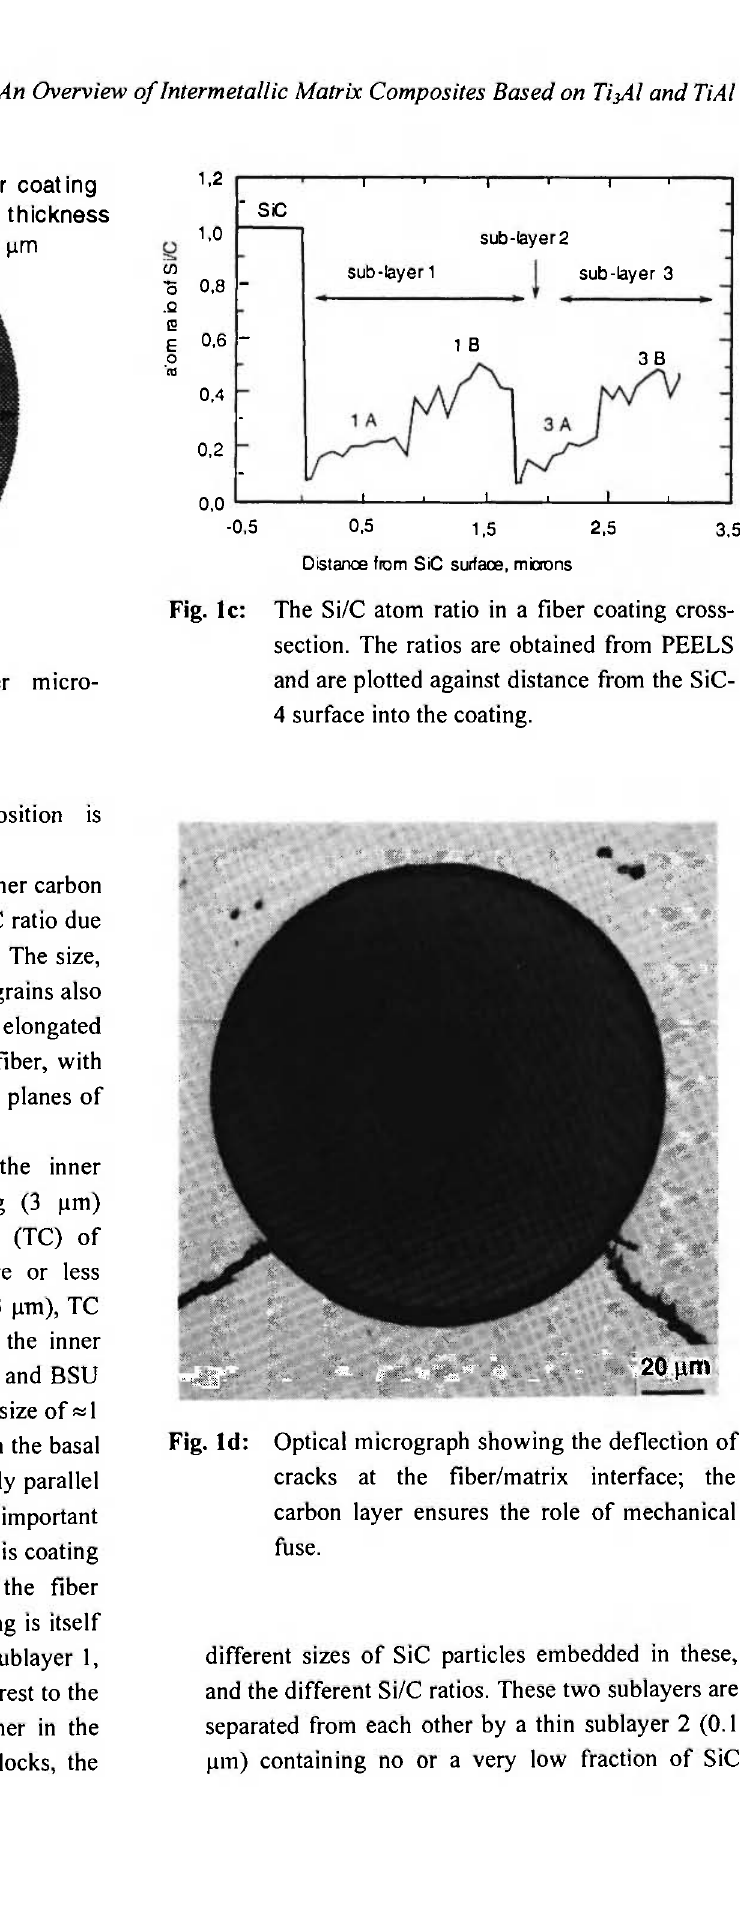
Fig. lc: The Si/C atom ratio in a fiber coating cross- section. The ratios are obtained from PEELS and are plotted against distance from the SiC- 4 surface into the coating.